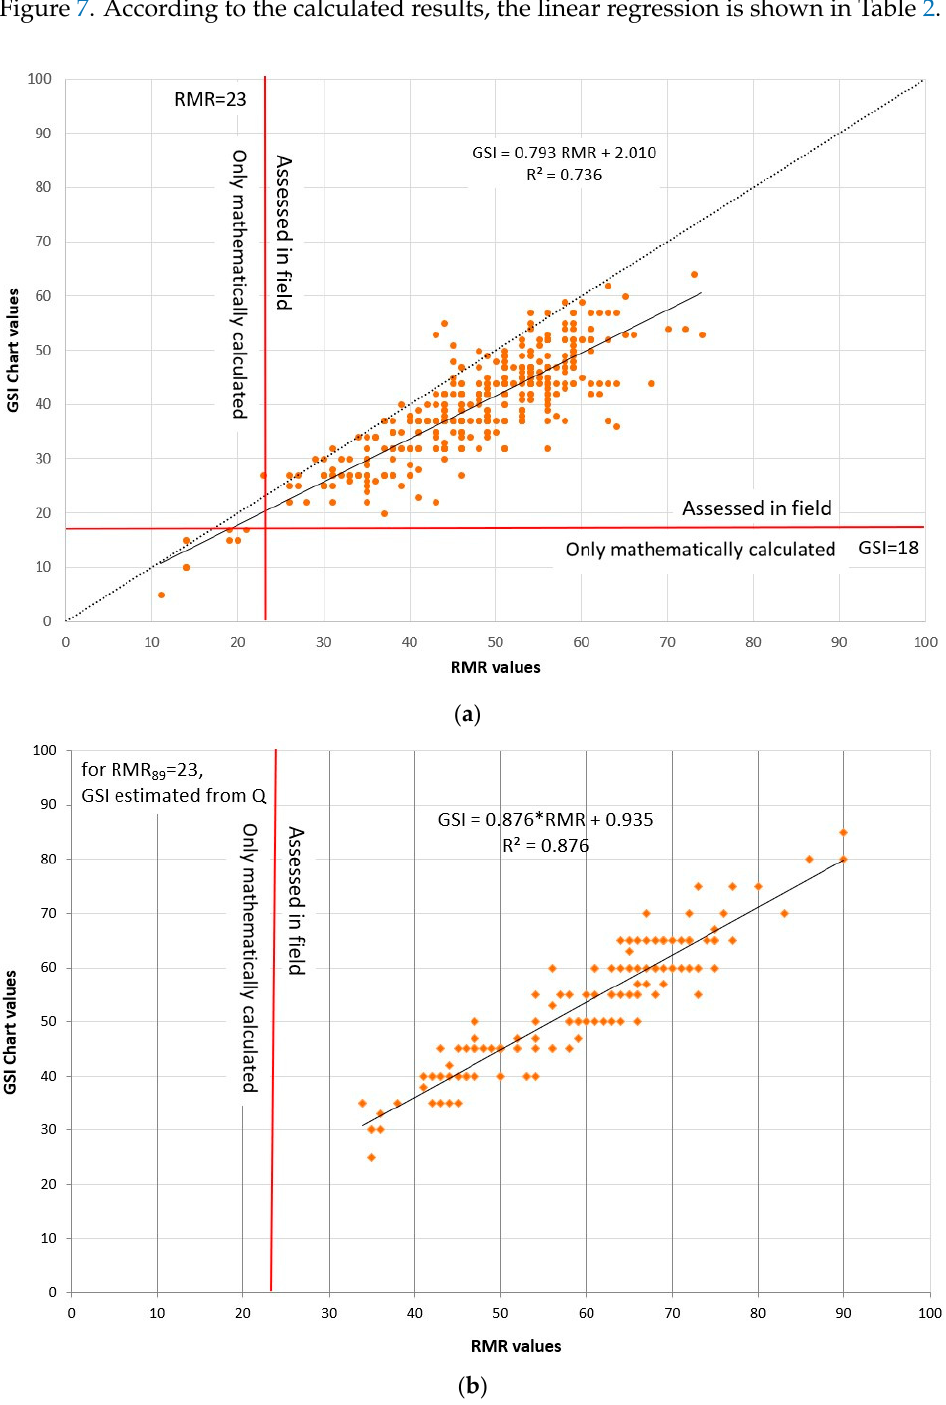
Figure 7. Correlation between Chart GSI and RMR values in Bátaapáti project ( a ), and in Telfer project ( b ).